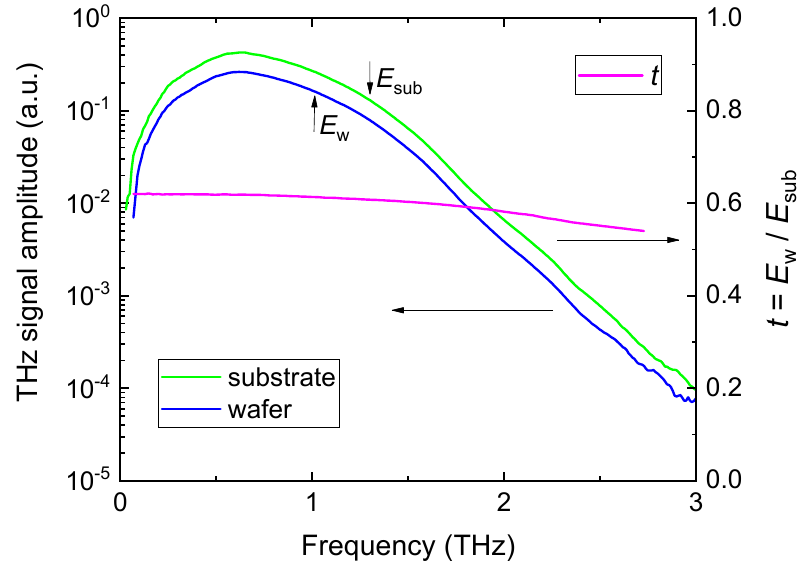
Figure 4. Spectra of THz beams transmitted through a bare substrate glass wafer and through a coated wafer, calculated from time-domain data in Figure 3, showing reduced transmission through the coated wafer. The red line (right-hand axis) shows the transmission ratio used to calculate frequency-resolved sheet